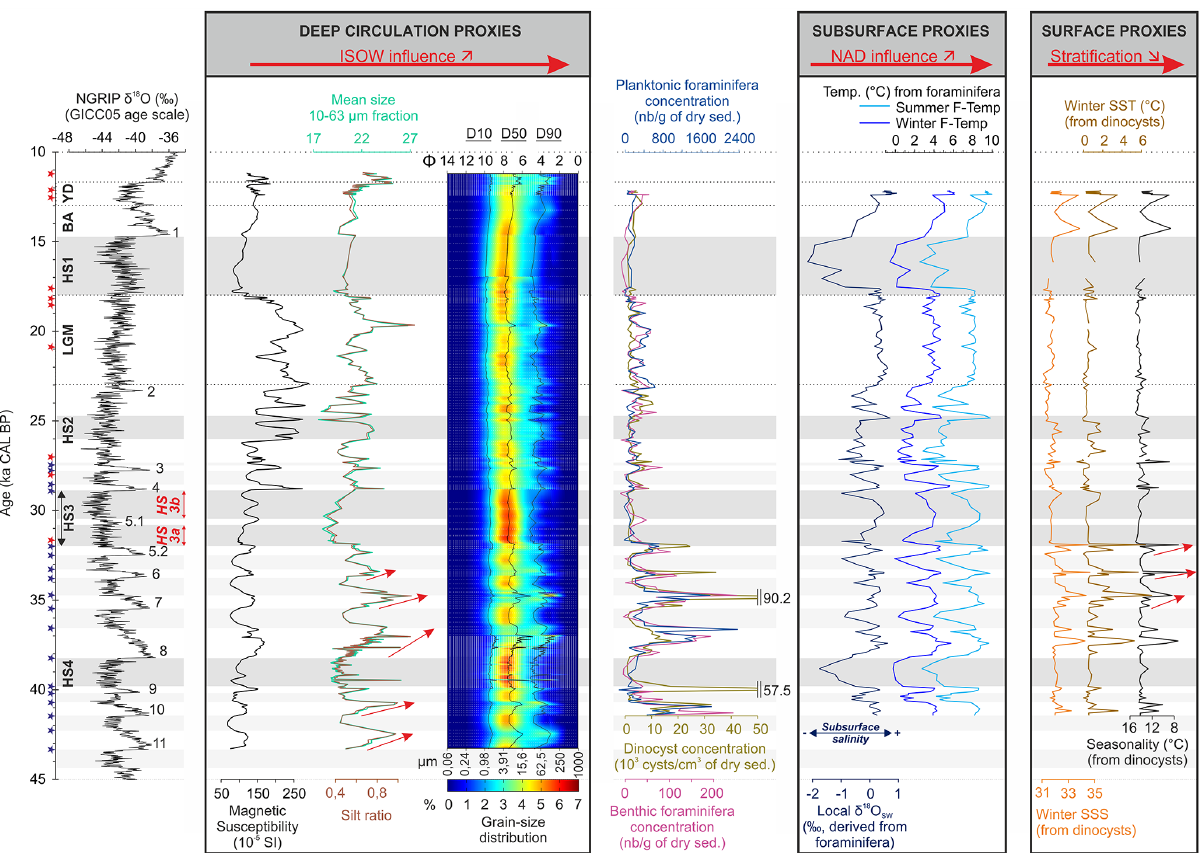
Figure 5. Comparative figure showing the evolution through time of proxies indicative of the ISOW bottom dynamics (left framed panel), the subsurface NAD intensity (middle framed panel), and the surface sensu stricto conditions (right framed panel). Absolute abundances of benthic foraminifera, planktonic foraminifera, and dinocysts are shown in the middle unframed panel. NGRIP δ 18 O record is shown at the far left to illustrate the chronological framework. Stars, bands, DO number and acronyms: same legend as Fig. 2. Red arrows highlight the progressive